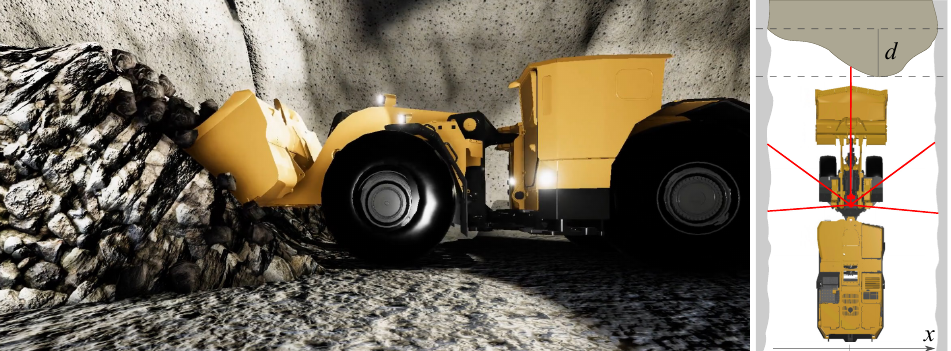
Figure 1. Image from a simulation of the LHD scooping muck from a pile. The right image shows a top view in which the positions of the lidar (five rays) and camera are